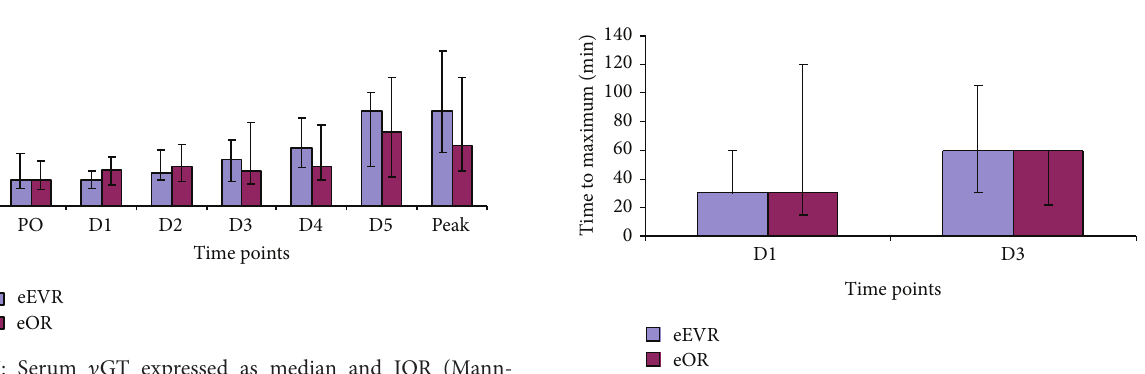
Figure 7: Serum 𝛾 GT expressed as median and IQR (Mann- Whitney 𝑈 test). At D4, 𝑃 = 0.005 , (D4 versus PO). At D5, 𝑃 = 0.003 , (D5 versus PO) in eEVAR group. 𝑃 = 0.04 , (D4 versus PO) in eOR group (wilcoxon signed Ranks test).